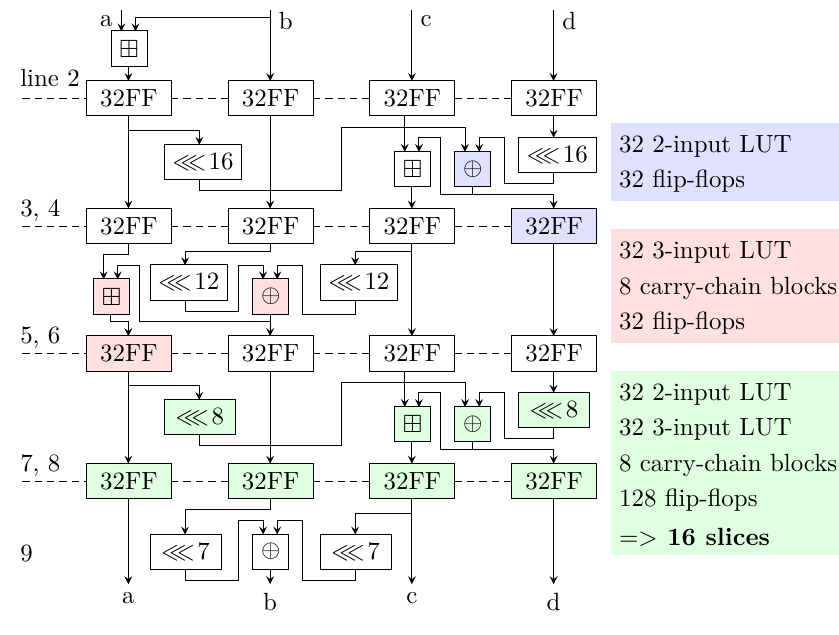
Figure 6: Quarterround, Algorithm